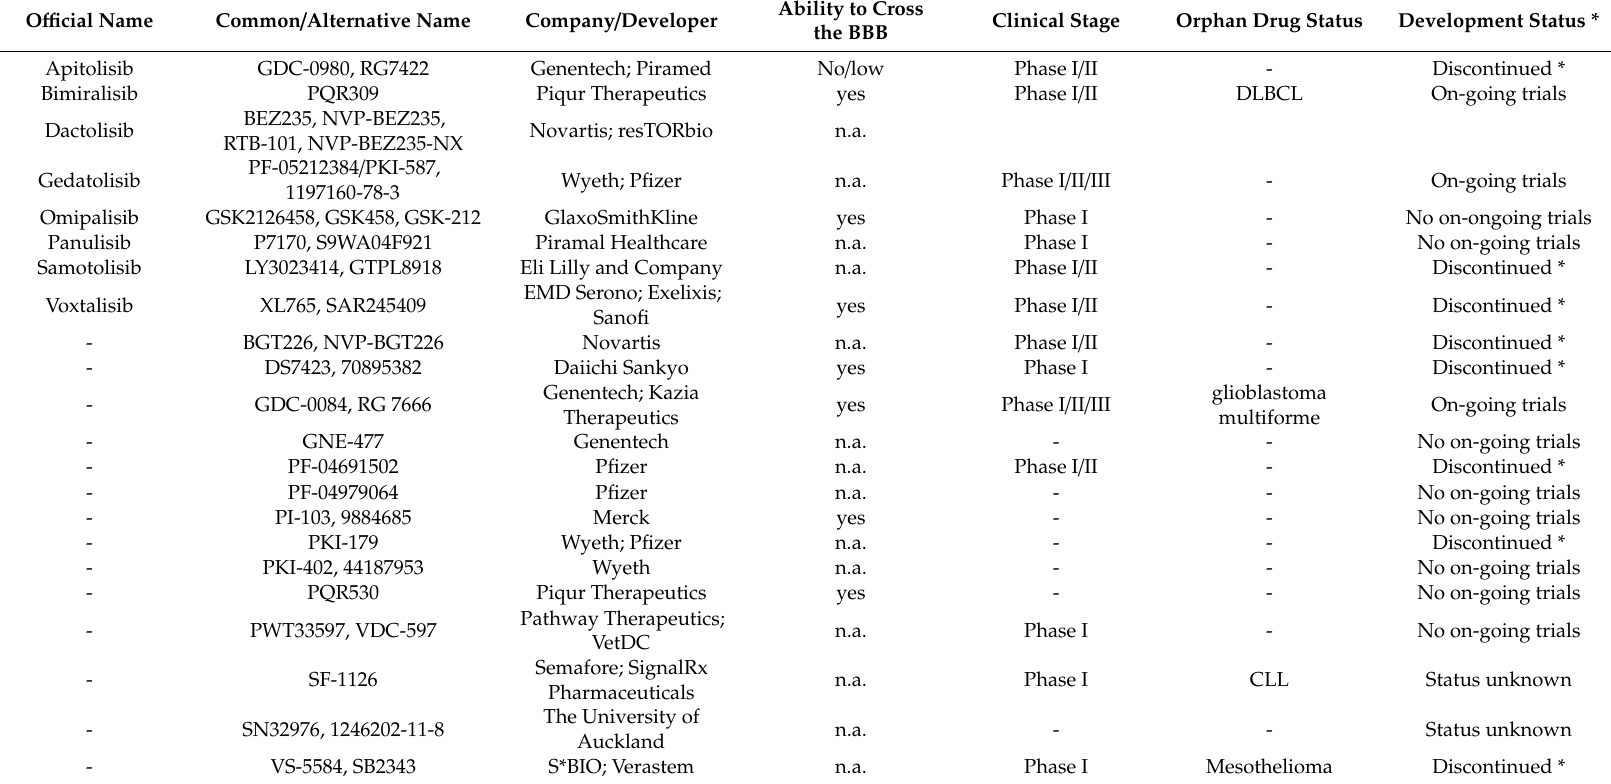
Table 1. List of dual Pi3K / mTOR inhibitors sorted by their o ffi cial name, if assigned, or by their common / alternative